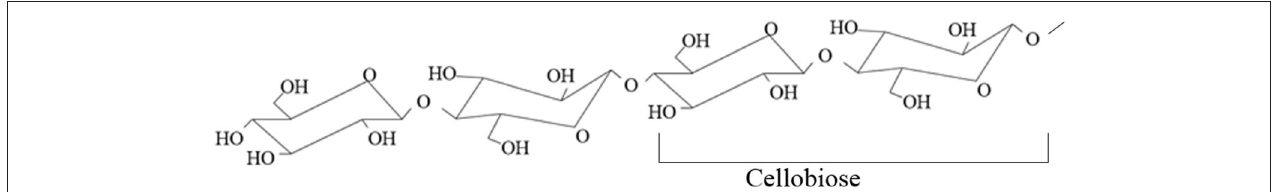
FIGURE 4 | Chemical structure of